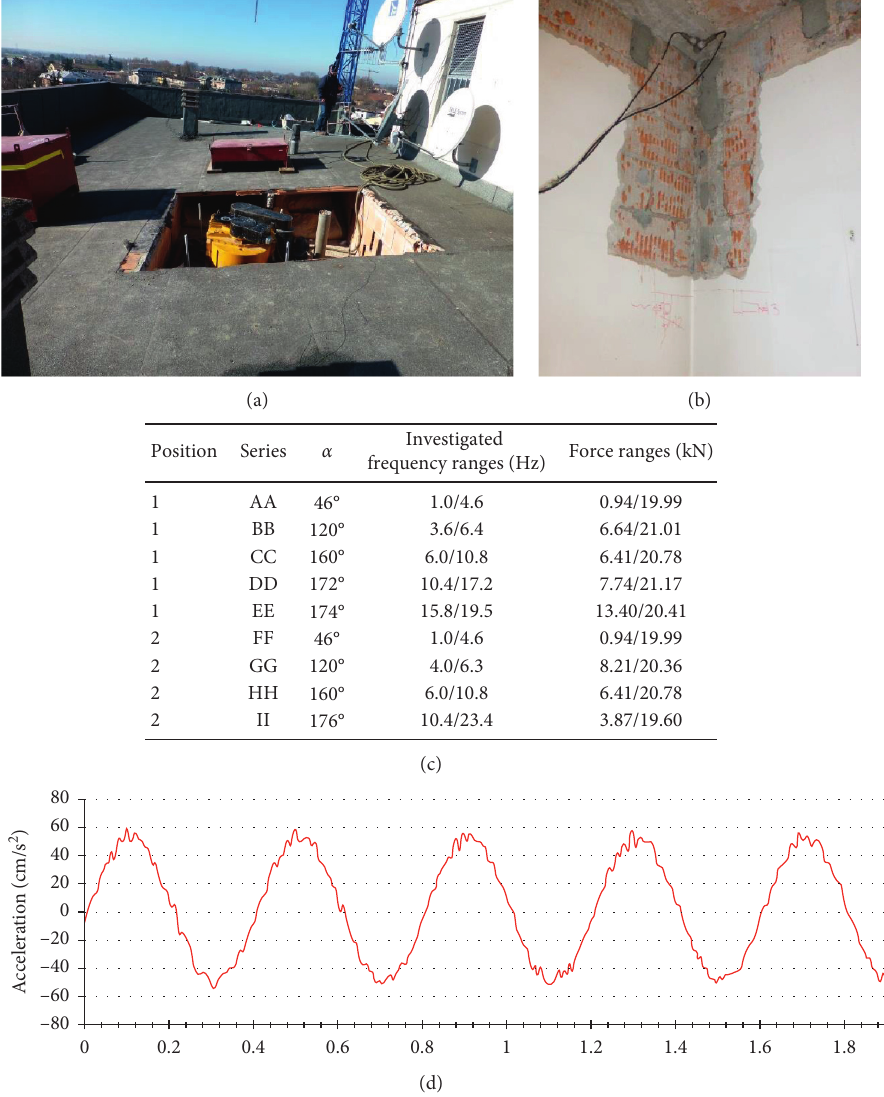
Figure 3: Instrumentation adopted during dynamic tests. (a) View of floor #7 with the vibration generator in Position #1. (b) Detail of the positioningofaccelerometersA3andA4.(c) Frequencyrangesinvestigatedwiththevibrationgenerator(extractedfromthetestreport).(d)Example of acceleration time history recorded by the accelerometer A4 during the series FF, for an excitation frequency equal to